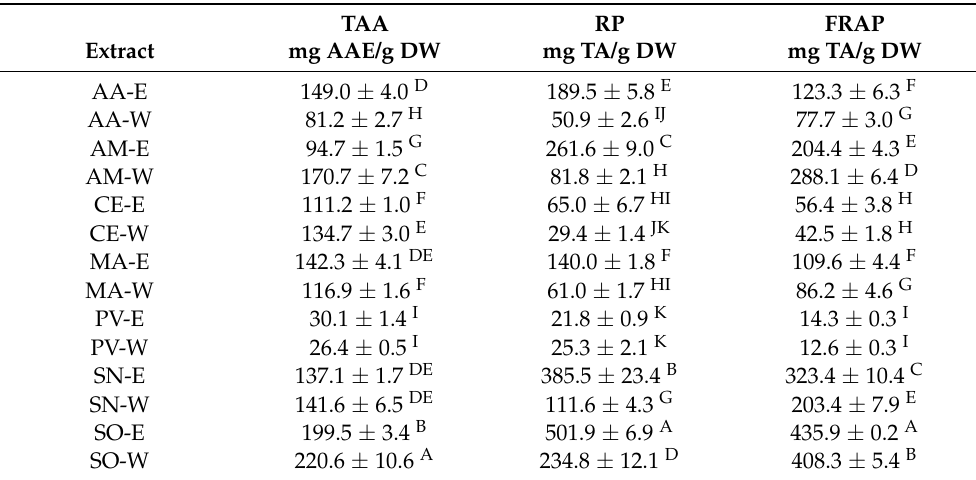
Figure 1. Antioxidant activity of the extracts and BHA (tested in the concentration of 8 µ g/mL) in β -carotene-linoleic acid assay (ANT). The extracts’ abbreviations are presented in Table 2. Values are the average of three replications ± SD. A–F = differences between the extracts within a column (extracts not connected with the same capital letter are statistically different, Tukey post-test, p < 0.05); X = differences with the positive control within a column (extracts not connected with the same capital letter are statistically different, Dunnet’s post-test, p < 0.05). Table 7. Total antioxidant activity (TAA), reducing power (RP), and ferric reducing power (FRAP) of the extracts.